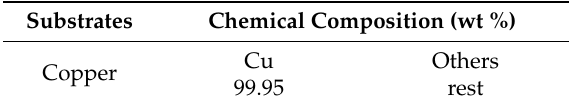
Table 1. Chemical composition of the copper substrates.